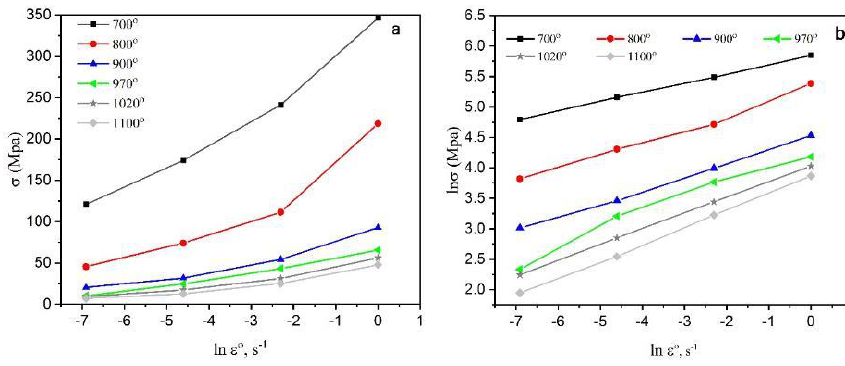
Fig. 5. Plot of (a) σ-lnε˚ (b)